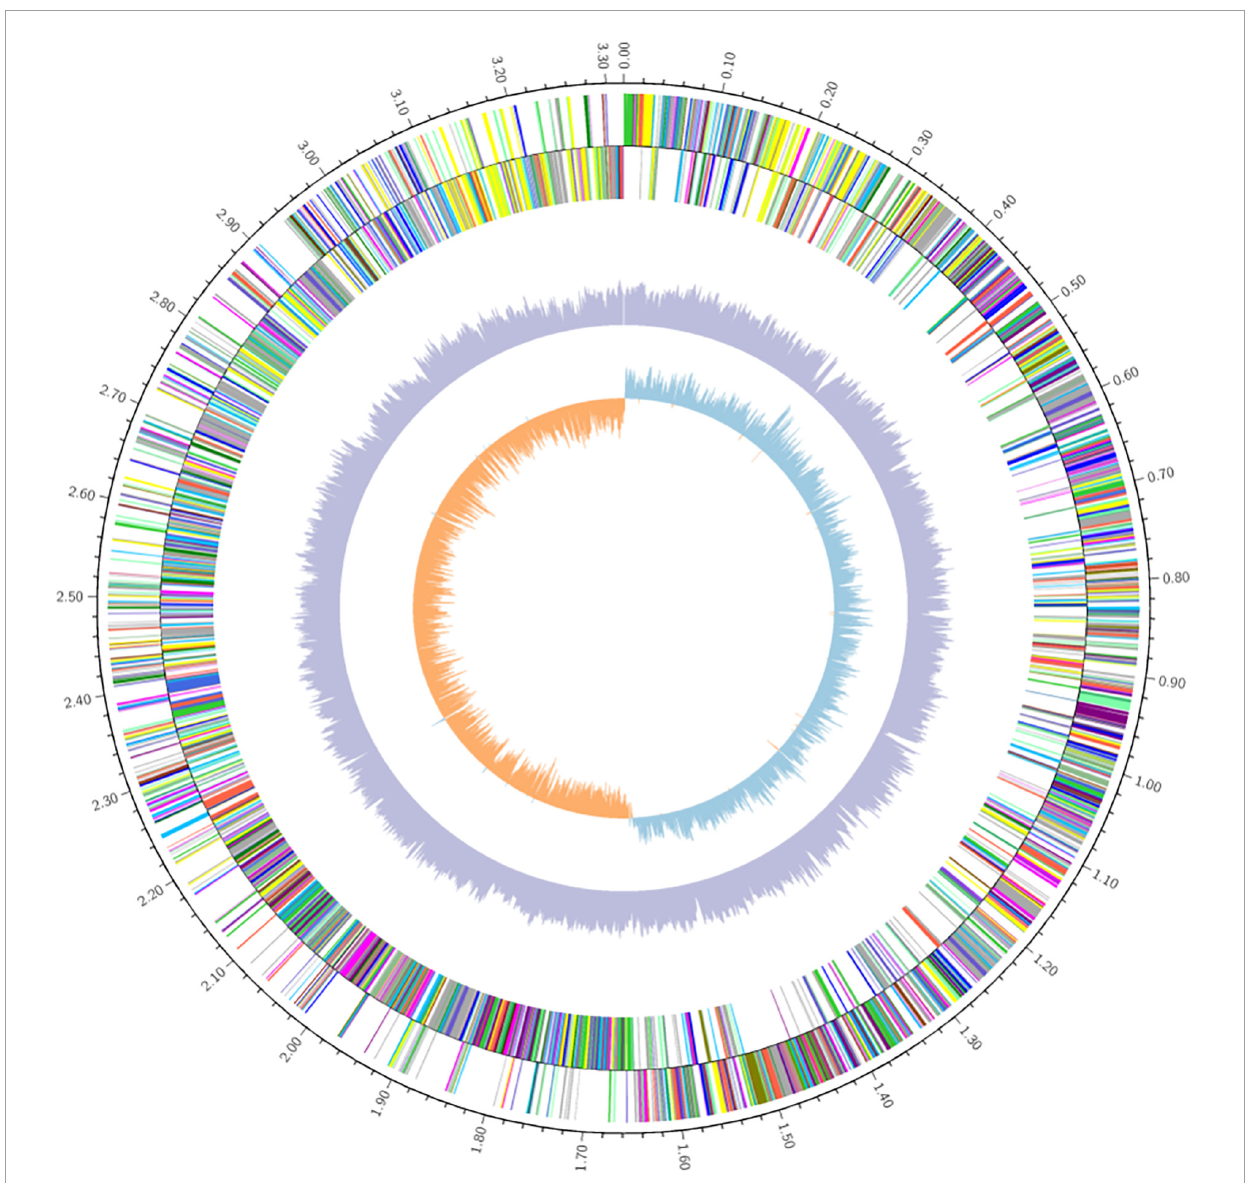
FIGURE1 Whole genome circle map of Lp. plantarum MC5. From inside to outside: GC skew, GC content, non-coding RNA (rRNA red, tRNA blue, sRNA green), lagging strand COG annotations, leading strand COG